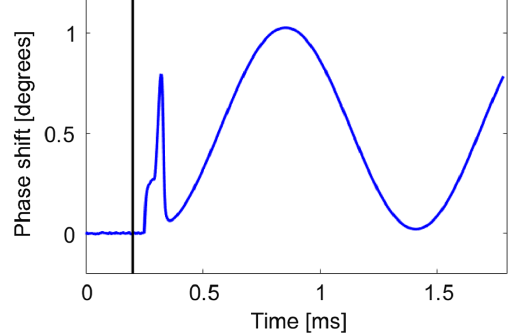
FIG. 12. Cavity phase vs time during a quench for an HL-LHC crab cavity under normal operating conditions.